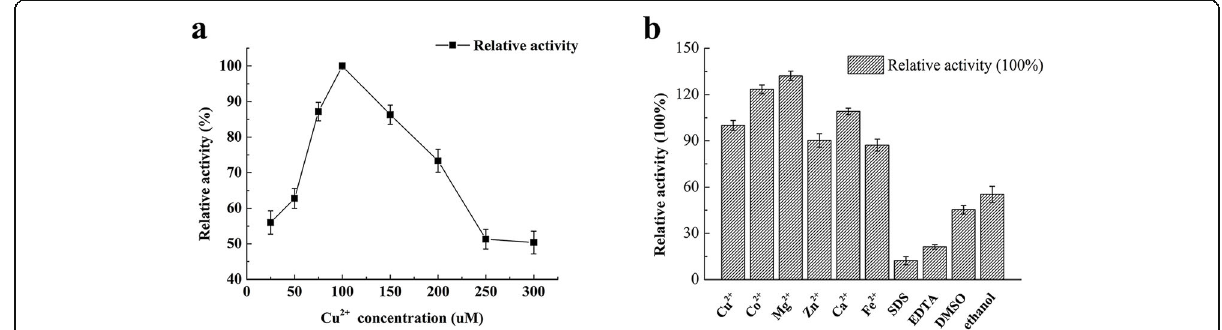
Fig. 4 Effects of Cu 2+ , metal ions, inhibitors, and organic solvent on the enzyme activity of LacAn. a Optimum Cu 2+ concentration of LacAn for enzyme activity was measured in 50 mM Na 2 HPO 4 -KH 2 PO 4 at 75 °C and pH 7.0 with syringaldazine as a substrate. b Effects of metal ions, inhibitors, and organic solvent on the enzyme activity of LacAn. The enzyme activity was measured in 50 mM Na 2 HPO 4 -KH 2 PO 4 at 75 °C and pH 7.0 with syringaldazine as a substrate, supplemented with 0.1 mM CuSO 4 . Error bars represent standard